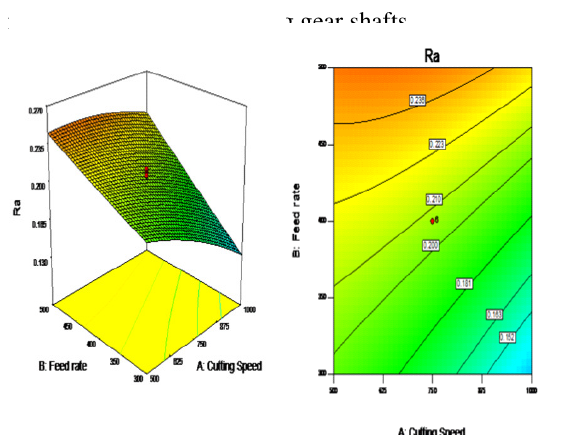
Fig. 6: 3D Response and Contour plot of Surface Roughness Vs Cutting Speed and Feed Rate